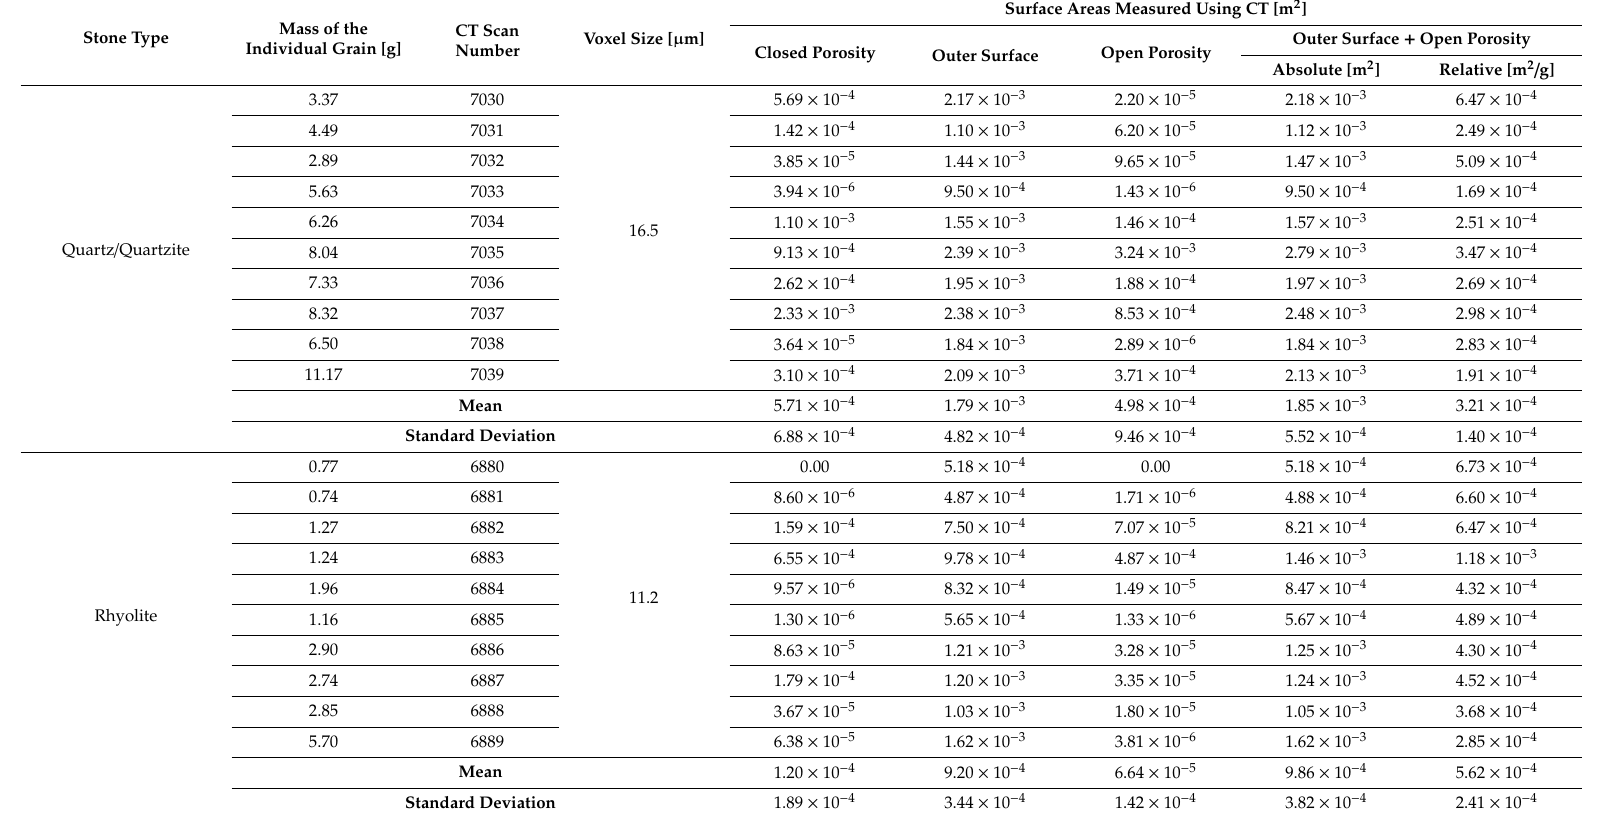
Table A1. Individual grain results from the cracking analysis of stone category GK1 (river gravel; alkali sensitivity